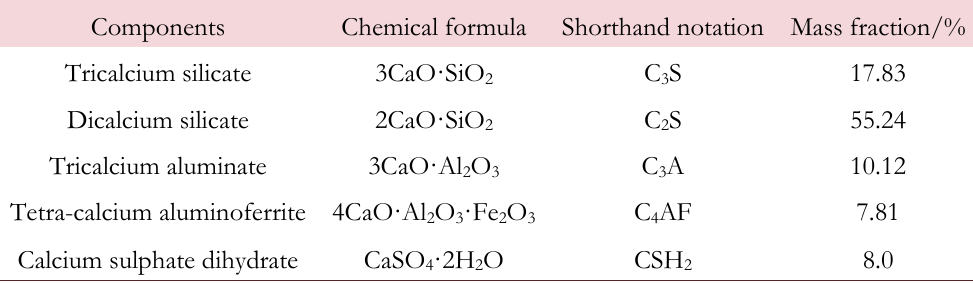
Table 1: Main components of